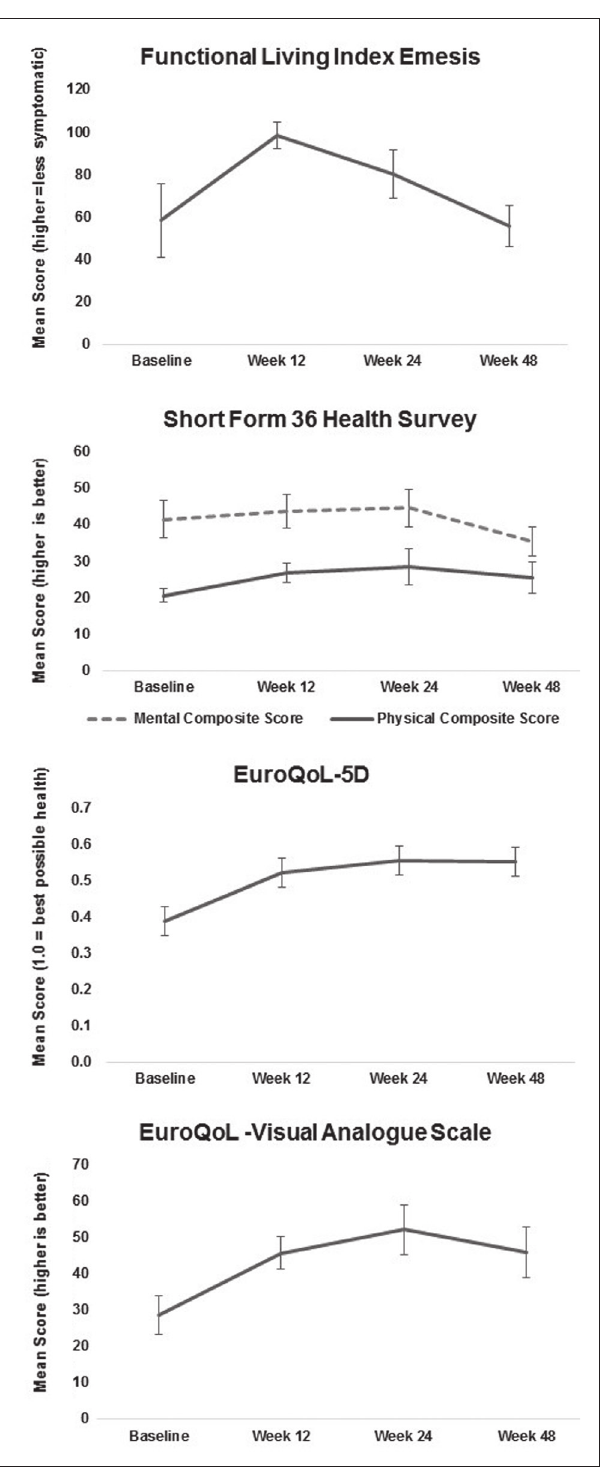
Figure 1) Quality of life questionnaire scores